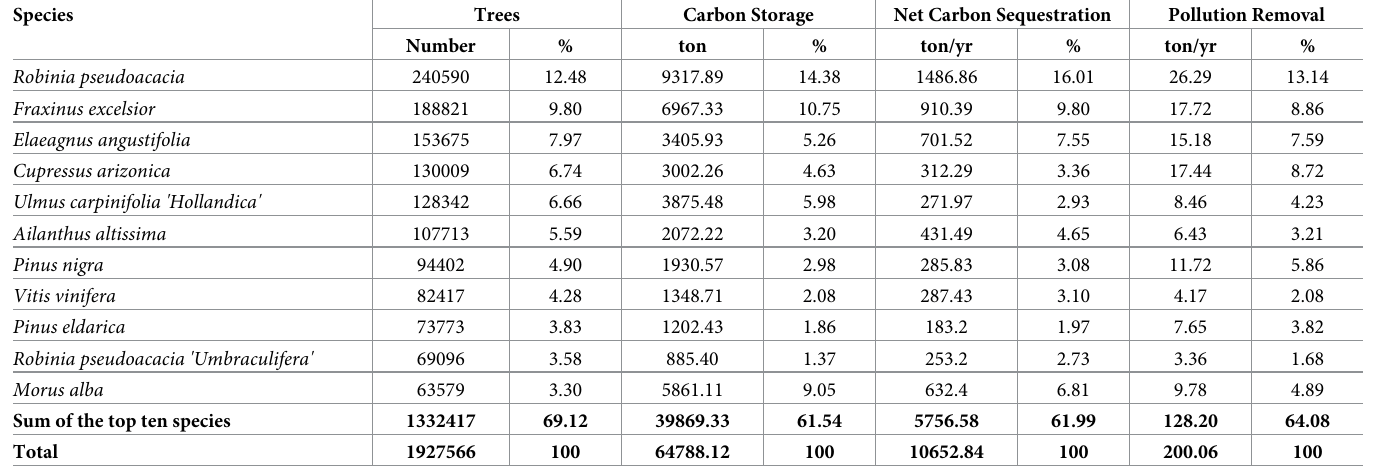
Table 2. Top ten species due to the provision of air quality improvement and carbon storage and sequestration.